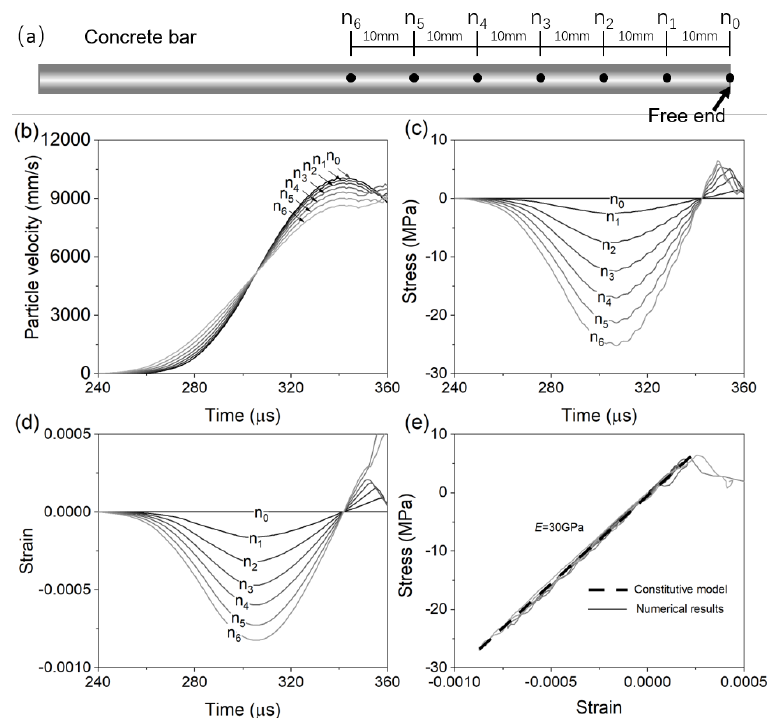
Figure 7. simulation results for a simplified spalling test model: ( a ) Illustration of seven representative nodes ( 0 to n 6 ), which are selected at 0 to 60 mm away from the free end. The spacing is 10 mm between two neighboring nodes; Simulated Profiles of particle velocity ( b ), stress ( c ), and strain ( d ) for each node; ( e ) Comparing the stress–strain curves obtained by the improved “1sv + nv” method against the constitutive profile defined in the FE